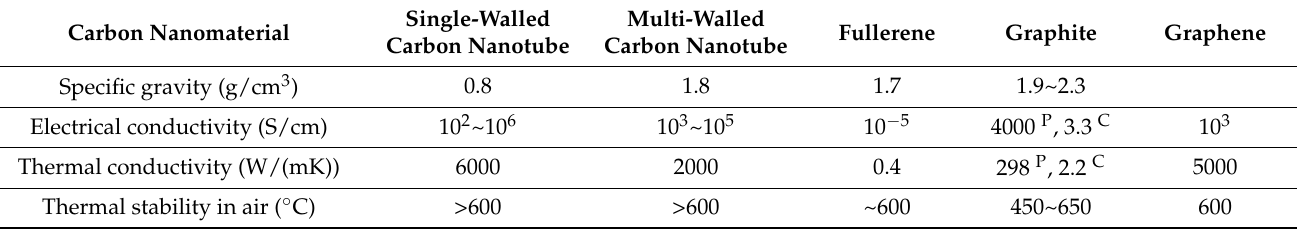
Figure 5. Structure of carbon nanotube ( a ) and graphene ( b ) [30]. Reproduced with permission. Table 1. The properties of different carbon nanomaterials [31].